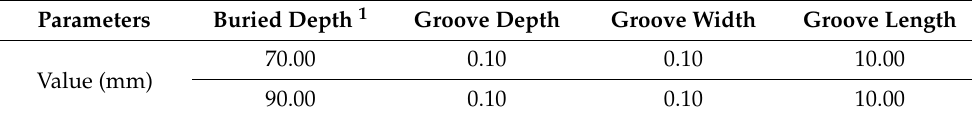
Table 3. Main parameters of two artificial